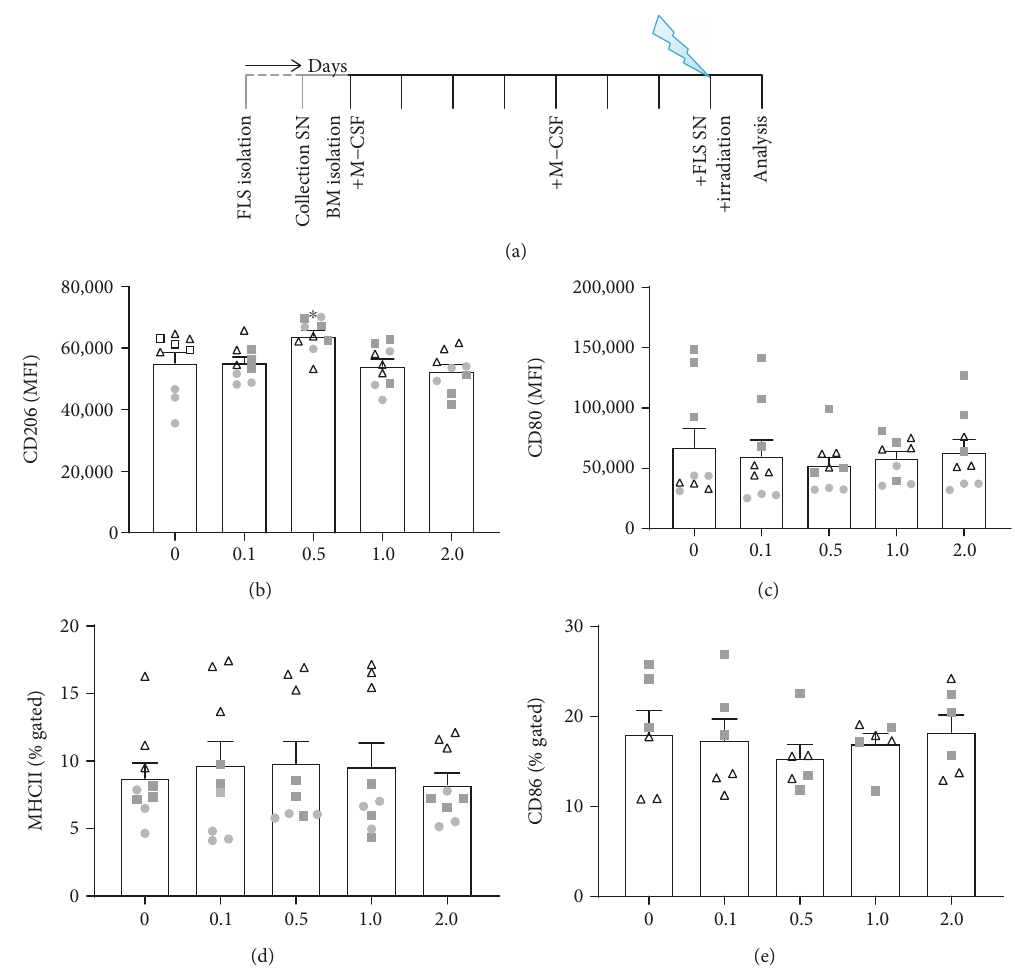
Figure 4: Irradiation with 0.5Gy alters fi broblast-like synoviocyte supernatant-stimulated macrophage phenotype. h TNF - α tg bone marrow cells were isolated and di ff erentiated with 5 ng/ml M-CSF into M0 macrophages according to the experimental set-up shown in (a). Prior to macrophage generation, fi broblast-like synoviocyte (FLS) cultures were generated and phenotyped. SN of FLS were collected and stored at -80 ° C until they were added to macrophage cultures 24 h prior to characterization of the macrophage phenotype and 2h prior to irradiation with the displayed doses of X-rays. The M2 macrophage marker CD206 (b) was signi fi cantly increased after irradiation with 0.5Gy. M1 macrophage markers CD80 (c) and CD86 (e) showed a slightly reduced surface expression again after irradiation with 0.5Gy, while the expression of MHCII (D) was not altered. Depicted is data from three independent experiments, each performed in triplicate (data points from one experiment are marked with equal symbols). Data is presented as the mean ± SEM . ∗ p < 0 05 . Representative histograms of the analyses are displayed in Supplementary Figure